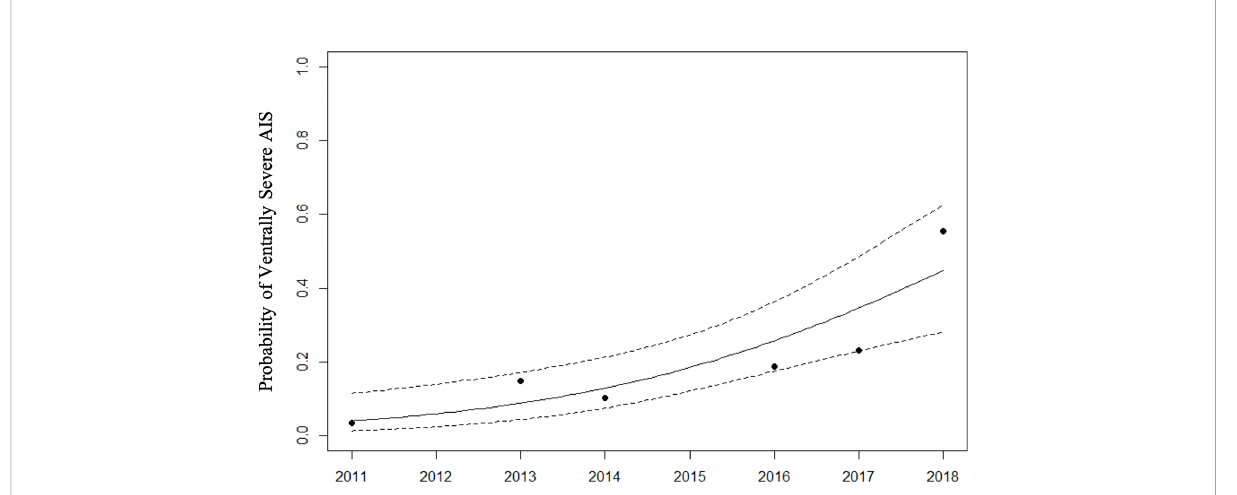
FIGURE 3 Probability of ventrally severe alveolar interstitial syndrome (AIS) in BB dolphins over years. Solid and dashed lines represent GAM model fi t and 95% con fi dence intervals. p-value for smooth term <